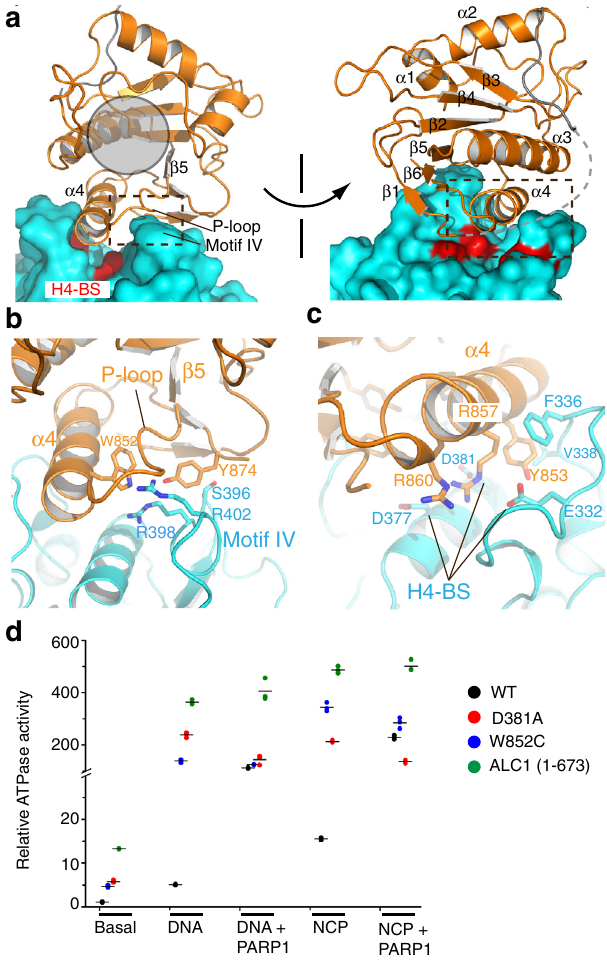
Fig. 2 Mechanisms of ALC1 autoinhibition. a Two different views of the macro-lobe 2 interaction. Lobe 2 is shown as a surface model. The position of the putative ADP-ribose binding pocket is indicated with a gray circle. Three acidic residues of the H4-binding surface (H4-BS) are colored red. The boxed regions are enlarged and analyzed in b , c . b Interaction between the macro domain and motif IV. c Interaction between the macro domain and the H4-binding surface. d ATPase activities of ALC1 and three mutants under different conditions. Basal: activity without DNA, NCP, or PARP1. All data points are showed with lines indicating the means ( n